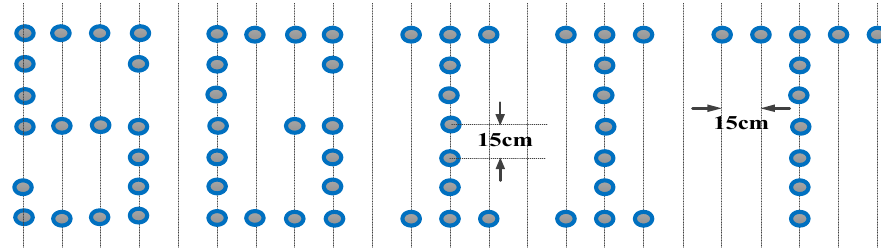
Figure 6. Imaging scene of point targets with the interval of 15 cm.